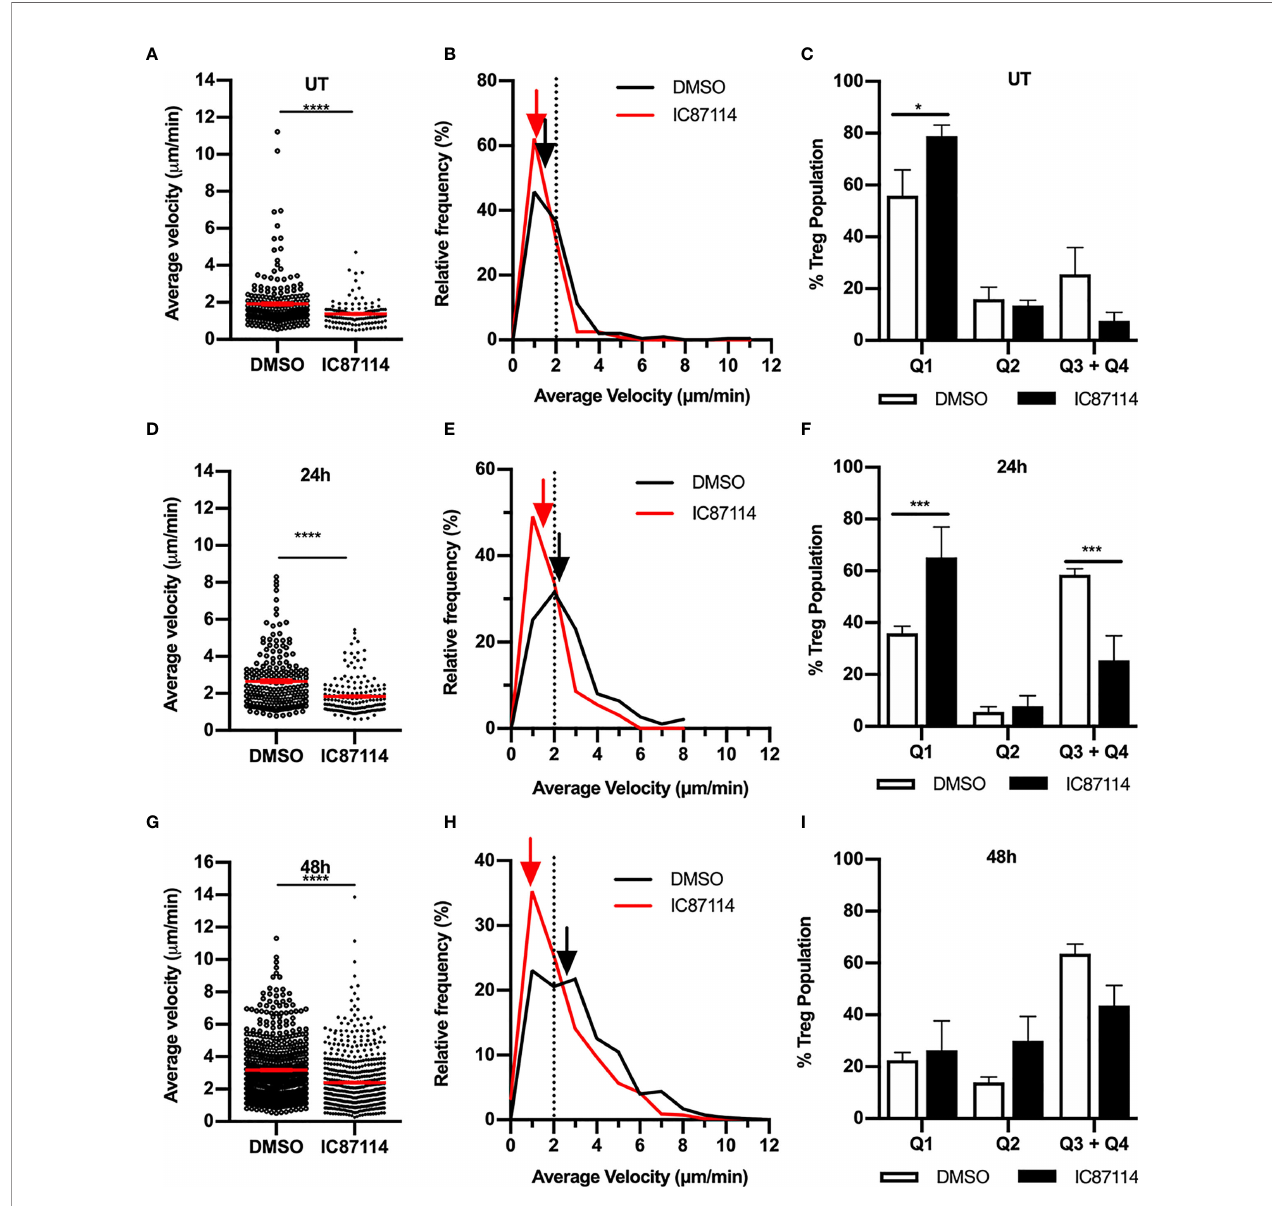
FIGURE 8 | Signalling through the PI3K p110 d subunit promotes Treg migration in resting and in fl amed skin. The impact of PI3K p110 d on dermal Treg migration was assessed using MP-IVM, following administration of IC87114 or DMSO vehicle 2 h prior to visualization by MP-IVM. Treg migration was assessed in untreated (UT) skin (A – C) , and 24 (D – F) and 48 h (G – I) post CS challenge. (A, D, G) Average velocities of Treg migration. Data show velocities for individual Tregs as well as group mean ± sem. (B, E, H) Relative frequency distributions of the average velocities of individual Tregs from IC87114-treated and control mice. Arrows indicate the median velocity, and the dotted line indicates the 2 µm/min threshold of motility. (C, F, I) Distributions of Tregs within the four quadrants of the velocity vs. con fi nement plots shown for UT mice, and 24 and 48 h post CS induction. Data represent the mean ± SEM of > 120 cells (UT) and > 300 cells (CS-challenged mice) derived from 3-7 mice/group. Quadrant data represent mean ± SEM of data averaged from 3 fov/mouse. Data in (A, D, G) were analysed by Mann-Whitney test. **** p < 0.0001 for comparisons shown. Data in (C, F, I) were analysed using a multiple comparison t test using the Holm-Sidak method (alpha 0.05). * p < 0.05, *** p < 0.001 for comparisons